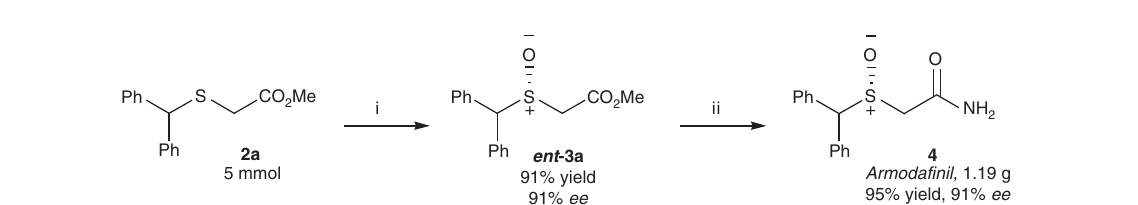
Figure 3 | Gram-scale synthesis of R -modafinil (armodafinil). Reaction conditions: (i) ( R , R )- 1a (0.25mol%), Na 2 MoO 4 (cid:3) 2H 2 O (2.5mol%), 35% aq. H 2 O 2 (1.05equiv.), KHSO 4 (0.5equiv.), n Bu 2 O (0.05M), rt, 8h; (ii) NH 3 (10.0equiv., 2M in MeOH), rt, 24h.